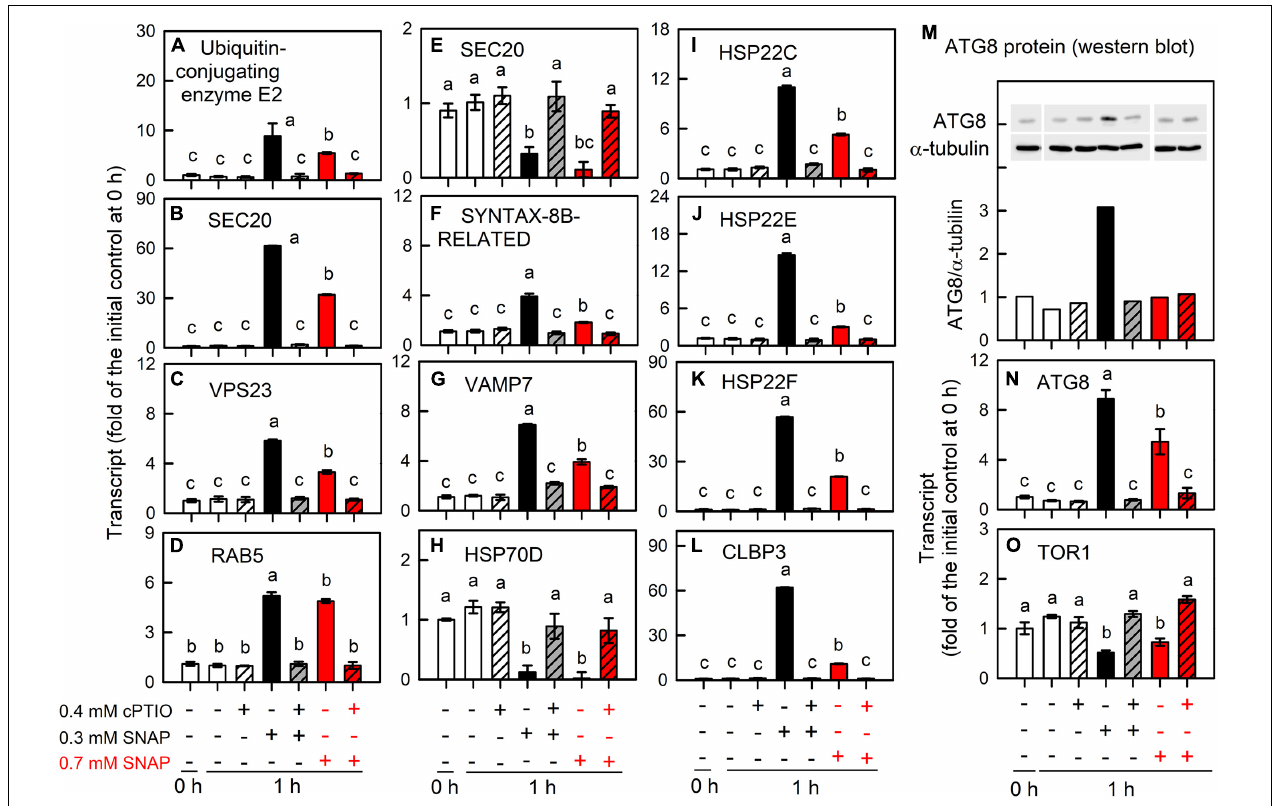
FIGURE 9 | Effects of 0.7 mM SNAP treatment on the expression of genes encoding protein trafficking system. The transcript abundances of A. Ubiquitin-conjugating enzyme E2 (A) , UBE3A (B) , VPS23 (C) , RAB5 (D) , SEC20 (E) , SYNTAX-8B-RELATED (F) , VAMP7 (G) , HSP70D (H) , HSP22C (I) , HSP22E (J) , HSP22F (K) , CLBP3 (L) , and ATG8 (N) , and TOR1 (O) ; the protein abundance of ATG8 (M) in C. reinhardtii 1 h after exposure to 0.7 mM SNAP in the presence or absence of 0.4 mM cPTIO. Data are expressed as the mean ± SD ( n = 3). Different symbols indicate significant differences between treatments (Scheffe’s test, P <